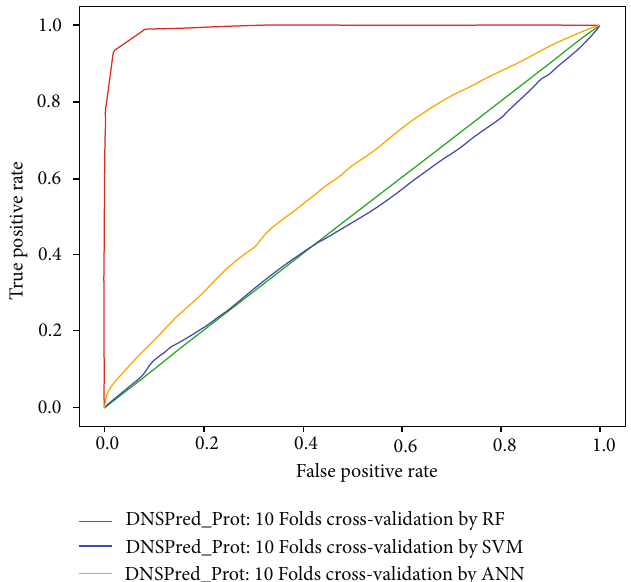
Figure 6: ROC comparison for 10-fold cross-validation.